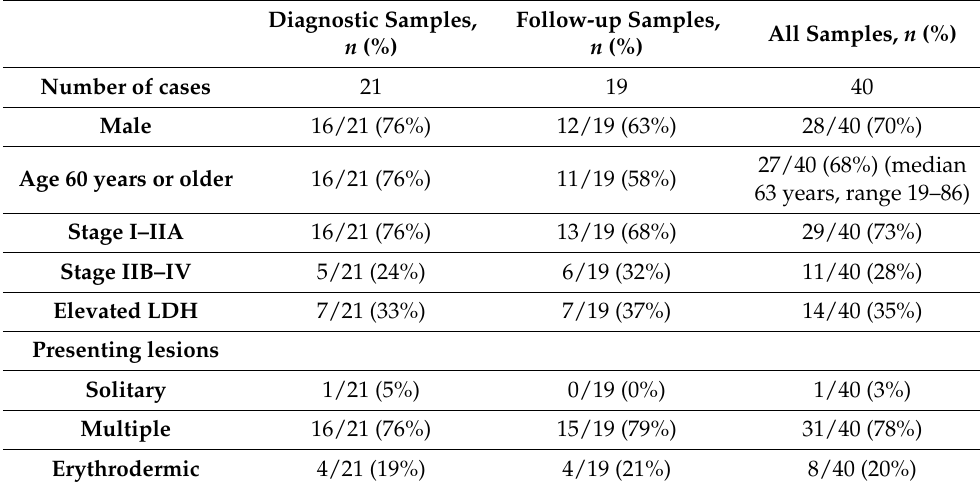
Table 1. Patient demographics: The median follow-up time was 32.2 months (range: 6.28–203 months). 6 duplicated patient samples were removed.